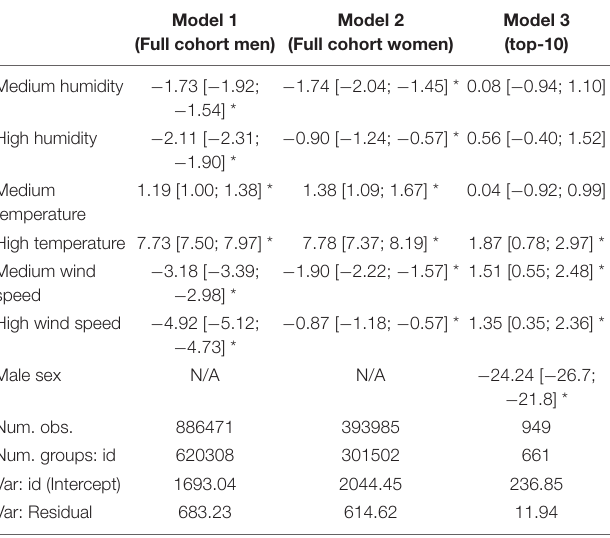
TABLE 2 | Linear mixed model with random intercept for race time